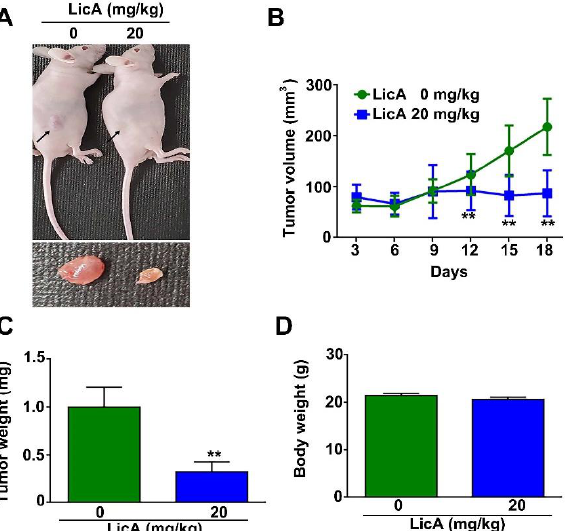
Figure 7. LicA suppresses tumor growth of RCC xenografts in vivo. ( A ) Representative images of the tumor tissues of the LicA-treated group and control group. ( B ) The tumor volume growth curve (mm 3 ). ( C ) Tumor weight and ( D ) body weight changes in mice in each group during treatment. N = 5 in control and LicA-treated groups. ** p < 0.01, compared to control group.